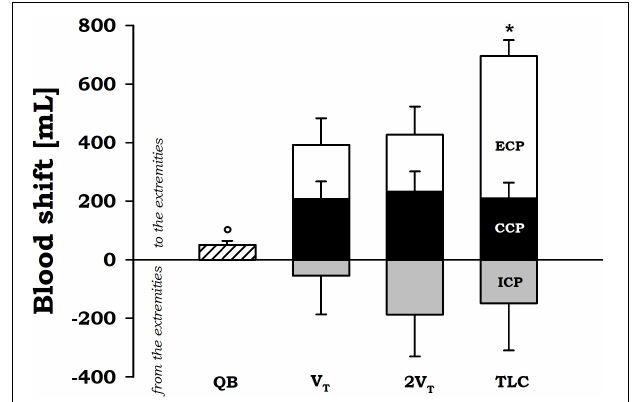
FIGURE 4 | Average values ± standard error of blood shift during quiet breathing (QB) (measured during expiration), inspiratory cough phase (ICP, gray bars), compressive cough phase (CCP, black bars), and expiratory cough phase (ECP, white bars) at each operating lung volumes: a tidal volume above functional residual capacity (V T ), total lung capacity (TLC), and an intermediate volume (2V T ). ∗ p < 0.05 vs. both V T and 2V T ; ◦ p < 0.05 vs. both CCP and